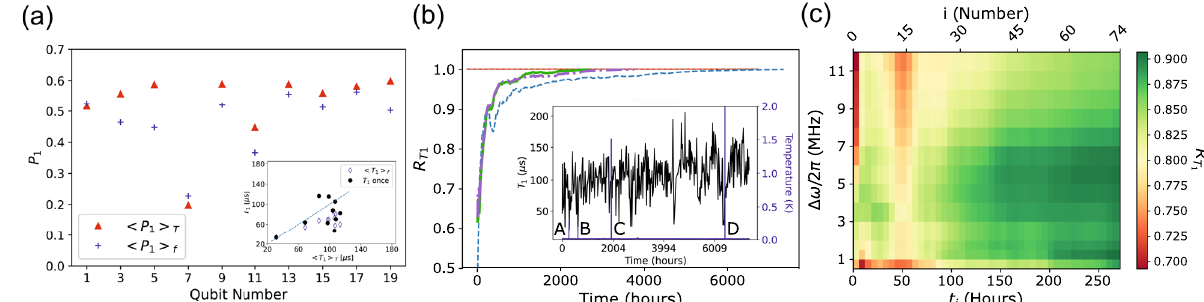
Fig. 5 Correlation between different T1 estimators. a Comparison of h P 1 i ω ; at 50 μ s and h P 1 i averaged for ~9 months and evaluated at a τ t T ’ s , is averaged over Δ ω /2 π = 5 MHz after a single measurement that took ~ 20 min. (inset) A scatter plot using h T 1 i of 53 μ s decay time. h P 1 i ω ; t T or T 1 s from a single day. The line is a guide to the eye showing averaged over 9 months of measurement as the dependent variable and h T 1 i ω ; t a 1:1 correlation. b The Pearson R dependence on time averaging of the T 1 ’ s of the odd numbered qubits up to time, T , for three cases: (i) the entire time series (dash), (ii) the time series between temperature excursion B and D (dash-dot), lettered locations indicated in the inset, and (iii) the time series between C and D for which no temperature excursions were recorded (solid). The intermediate time series are shifted in time index to compare more directly at short times with the full-time series. The differences in R are within the standard deviation calculated for sampling T 1 time series with a Gaussian-distributed range of values, see supplemental information S4. (inset) The T 1 (black, left) and mixing chamber temperature (blue, right) time series for Q 13 . Spacing of measurements is non-uniform. The minimum spacing is ~ 24 h apart. Each temperature excursion is labeled with a letter. c Pearson correlation, R , dependence on time slice averaging and frequency range, Δ ω , of the odd numbered